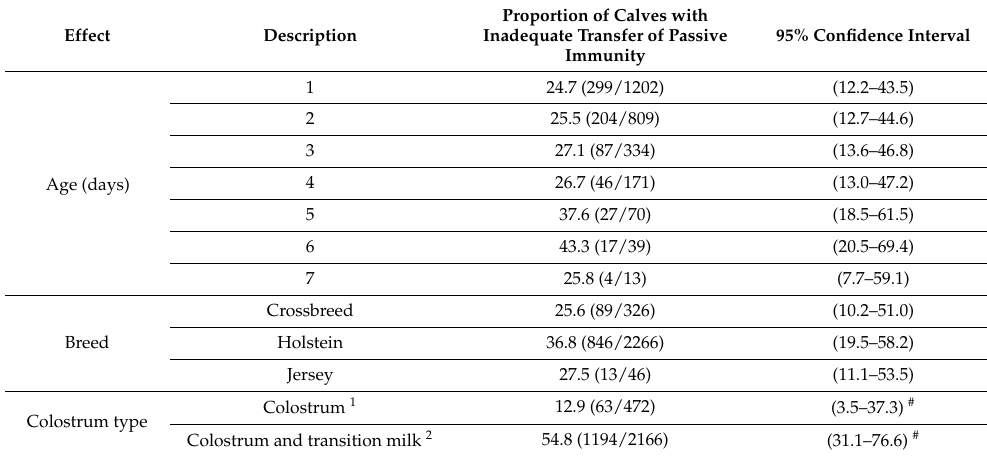
Table 5. Proportion of heifer calves with inadequate transfer of passive immunity (95% confidence intervals) for a variety of factors, from five dairy farms in South Australia, adjusted for the effects of farm and frequency of calf collection from calving paddock per day. The transfer of passive immunity was estimated using serum